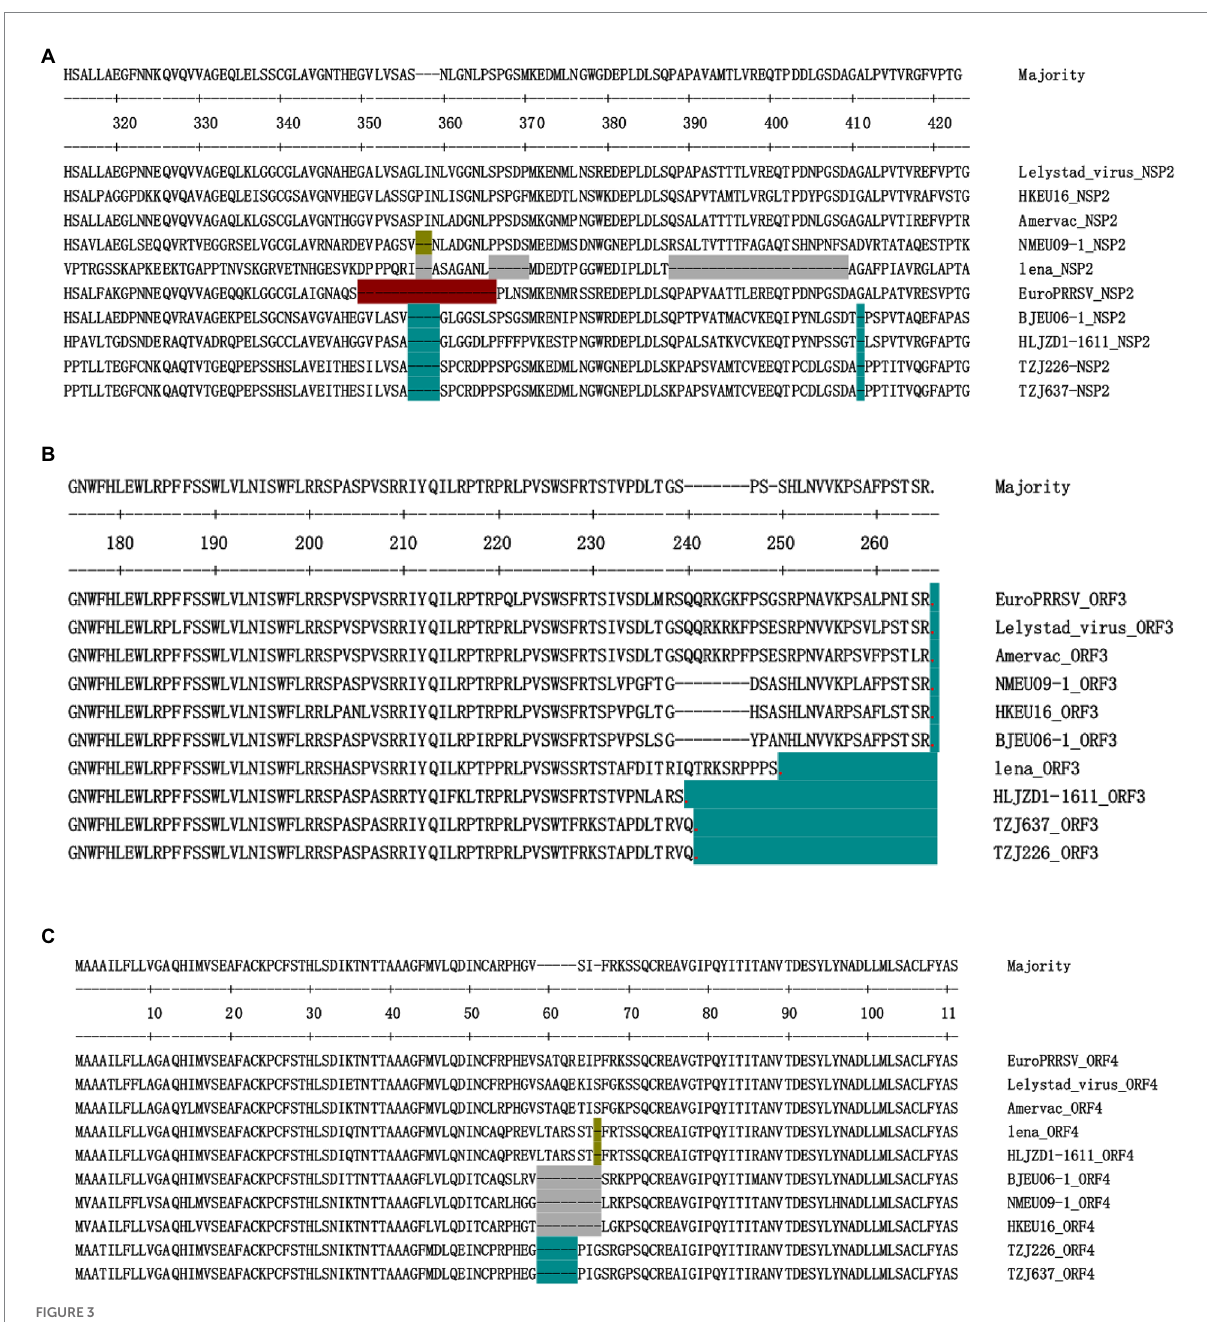
FIGURE 3 Identification of PRRSV strains with amino acid deletions in NSP2, ORF3 and ORF4. (A) Sequence alignment of NSP2 proteins, different aa deletion patterns are indicated by different colors. Similar to the BJEU06-1 strain, TZJ226 and TZJ637 PRRSV show deletions of 4 amino acids and 1 amino acid, respectively, corresponding to positions 356–359 and 411 of the Lelystad NSP2 protein. (B) Sequence alignment of ORF3 proteins. Stop codons are represented by red dots, and the number of amino acids lacking due to premature termination relative to Lelystad is indicated by an azure background. (C) Sequence alignment of ORF4 proteins, different aa deletion patterns are indicated by different colors. TZJ226 and TZJ637 shared the same 5-aa deletion, labeled with an azure background, corresponding to positions 59–63 of the Lelystad NSP2 protein. The positions marked in the figure represent the positions of the amino acid sequences and refer to the positions in